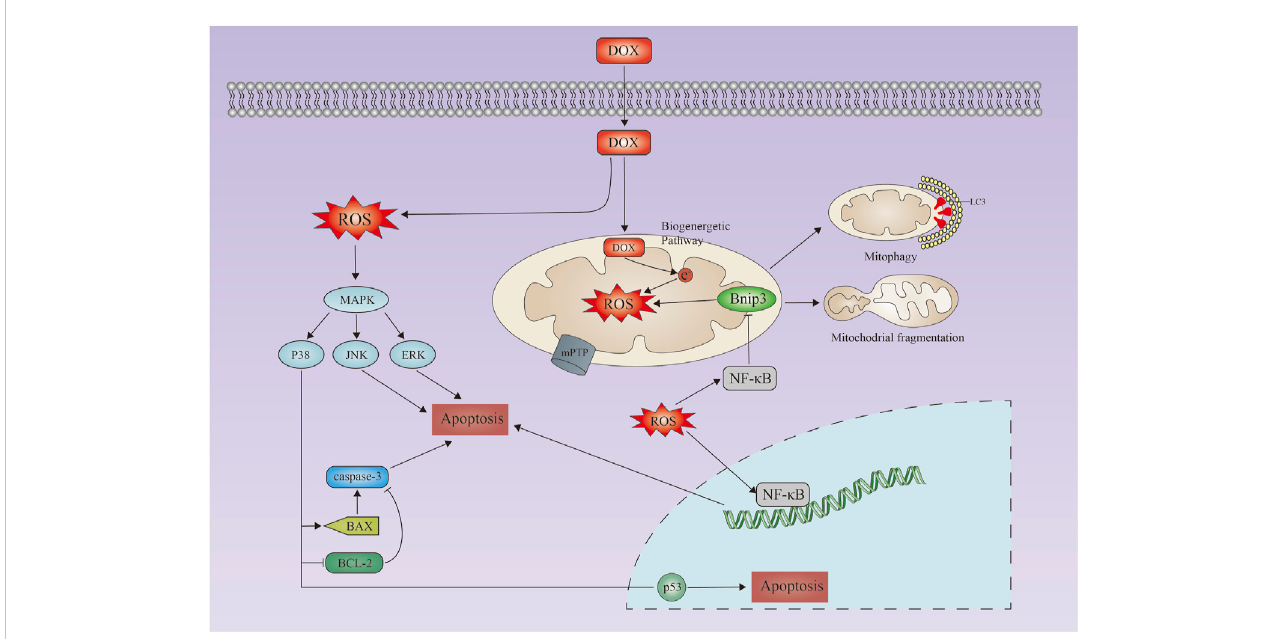
FIGURE 1 Doxorubicin-induced apoptosis in cardiacmyocytes. Schematic representation of doxorubicin-induced apoptosis in cardiac myocytes. Doxorubicin induces increased reactive oxygen species production, activation of the MAPK pathway, upregulation of Bax/Bak, and activation of caspases 3, leading to apoptosis. Mitochondrial calcium overload and activation of the mitochondrial permeability transition pore (mPTP) lead to loss of mitochondrial membrane potential, mitochondrial swelling, and outer membrane rupture. DOX, doxorubicin; MAPK, mitogen-activated protein kinase; JNK, Jun amino-terminal kinase; ERK, extracellular signal-regulated